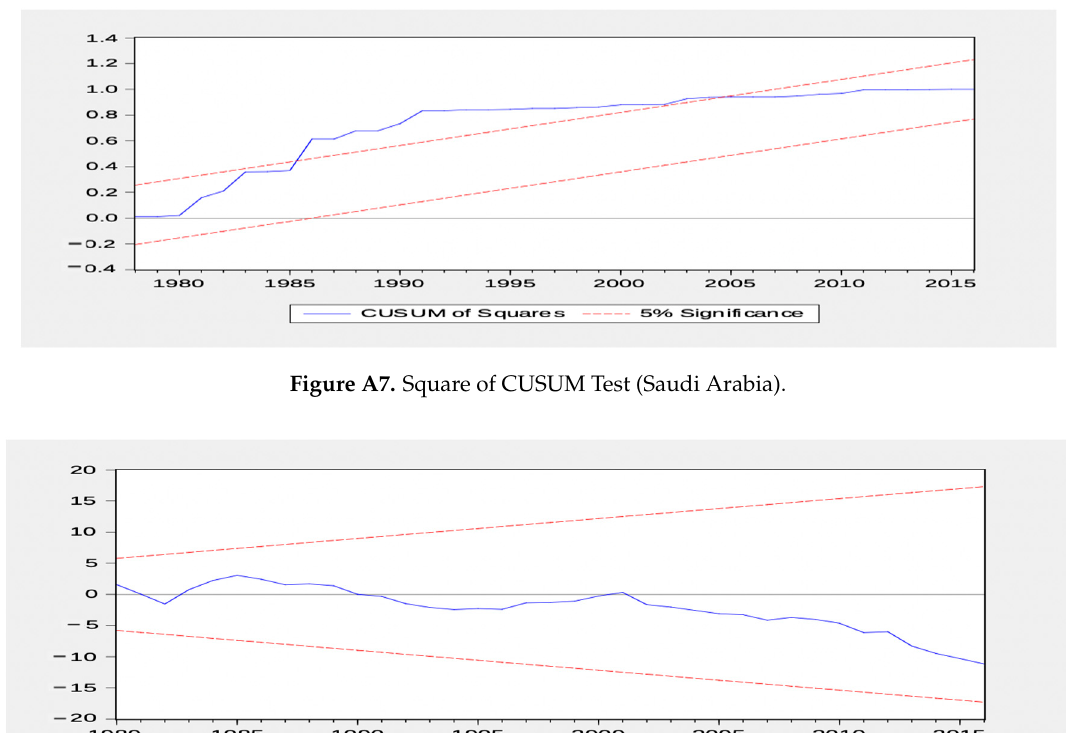
Figure A6. CUSUM Test (Saudi Arabia).